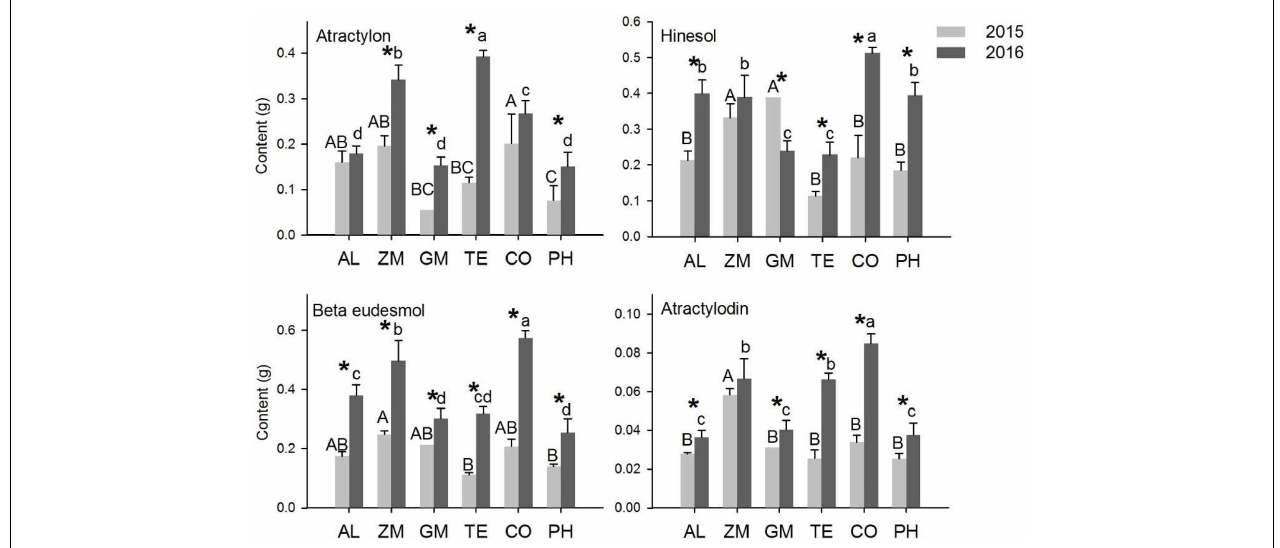
FIGURE 5 | The effect of different intercropping treatments on the contents of four volatile oils in 2015 and 2016. Different capital (2015) and lowercase (2016) letters indicate a significant difference at the 5% significance level, and asterisks indicate significant differences between 2015 and 2016 within individual treatments.